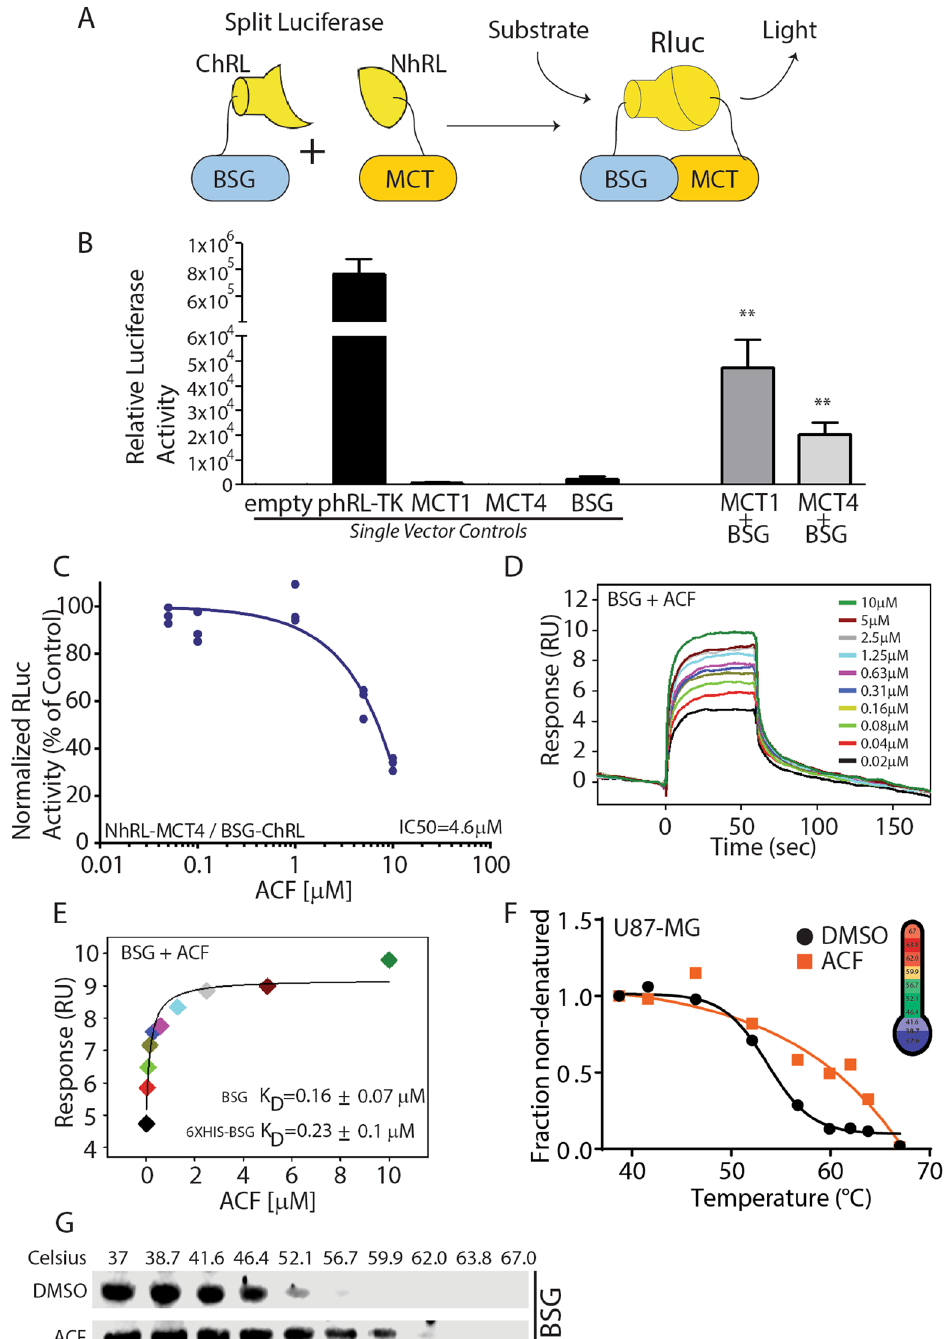
Figure 1. ACF Binds BSG and Inhibits the MCT/BSG Interaction. ( A ) Split Renilla luciferase (Rluc) system for identifying inhibitors of MCT/BSG Interaction. N-terminal and C-terminal portions of Rluc were attached to MCT (MCT1 and MCT4) and BSG, respectively. ( B ) The ratio of Renilla/Firefly luciferase activity (Rluc/Fluc) was determined using HEK293 cells co-transfected with pCDNA3, which encodes Fluc, with the indicated constructs. Each value was then normalized to the results for an empty vector. Data represents mean ± SD (n = 3). ** P < 0.01 (Student’s t-test) vs. samples lacking BSG. ( C ) Dose dependency curve for NhRL-MCT4 and BSG-ChRL interaction. IC50 = 4.6 μ M. ( D , E ) Surface plasmon resonance (SPR) analyses were used to determine the equilibrium dissociation constant (KD) between Basigin and ACF. Sensorgrams ( D ) and a fitting curve ( E ) are shown. Experiments were performed in triplicates and comparison was made between native BSG and 6X-HIS BSG with similar KD values of 0.16 + / − 0.07 and 0.23 + / − 0.1, respectively. ( F ) A representative cellular thermal shift assay (CETSA) analysis for U87-MG GBM cells treated with ACF or vehicle (DMSO) showing ACF increases BSG’s melting temperature, therefore, providing further evidence for direct drug/target interaction in live cells. ( G ) A representative western blot analysis of CETSA